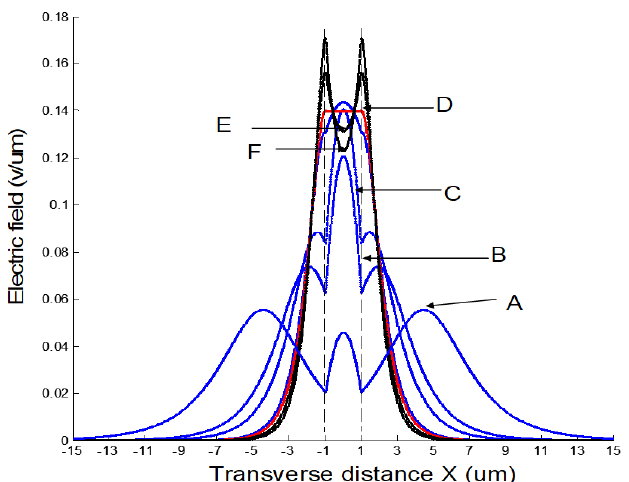
Figure 3. The electric field distributions with respect to the six points, A, B, C, D, E, and F, shown in Figure 2. in Figure